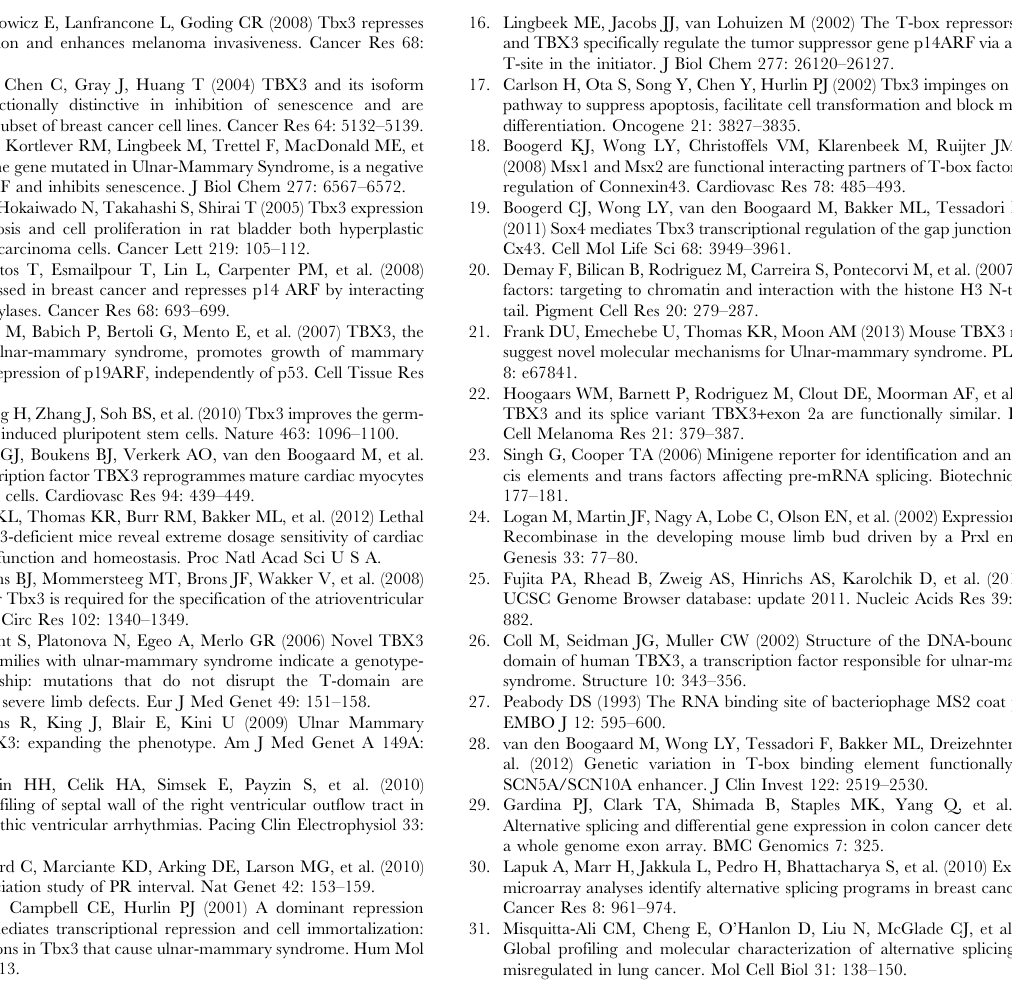
Table S4 Location of putative TBEs and MEME motifs for the 11 validated alternative splicing events in the anterior limb compartment. Primary sequences of alternatively spliced exon and 1 kb of 5 9 and 3 9 flanking regions. Introns, exons, motifs and conservation are as noted in the